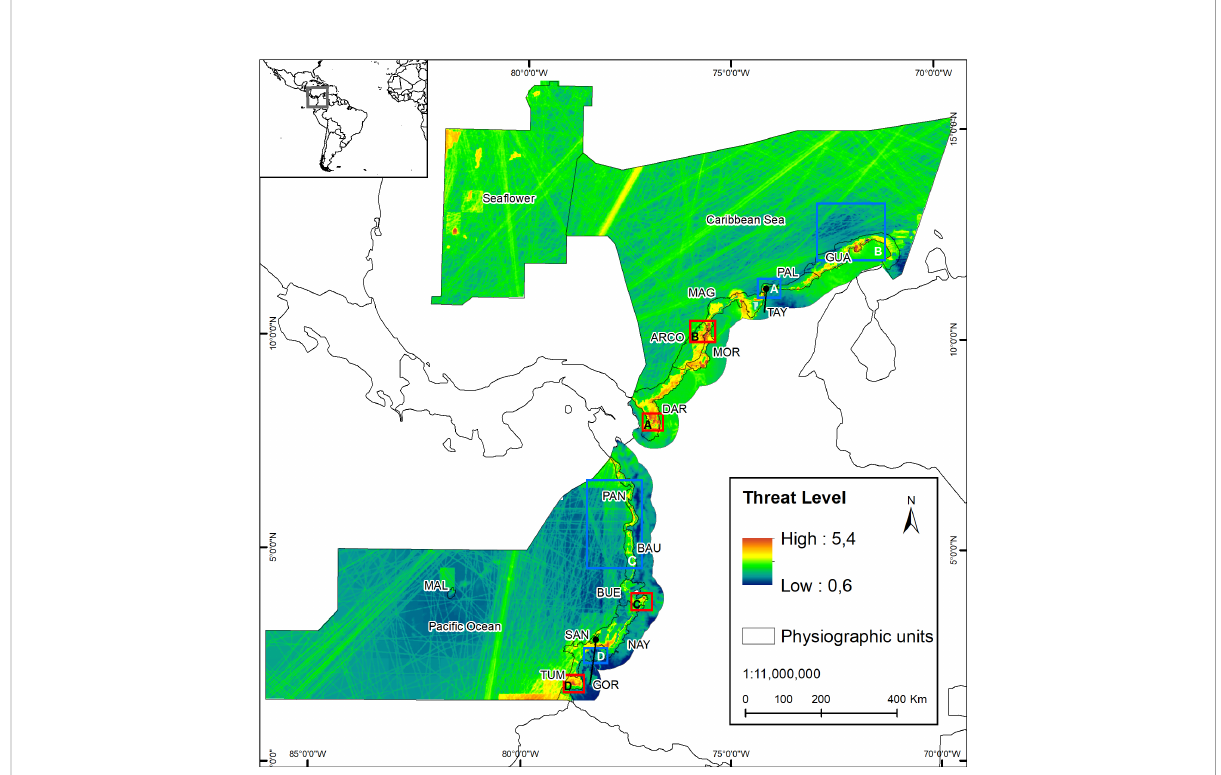
FIGURE 2 Cumulative threat map. Sum of all individual threat levels (TLs) in marine and coastal environments. Black polygons represent physiographic units according to INVEMAR (full names are provided in Table 4). Threat hotspots (red squares) and coldspots (blue squares) are shown within the study area and identi fi ed by letters, as shown in Figures 3 and